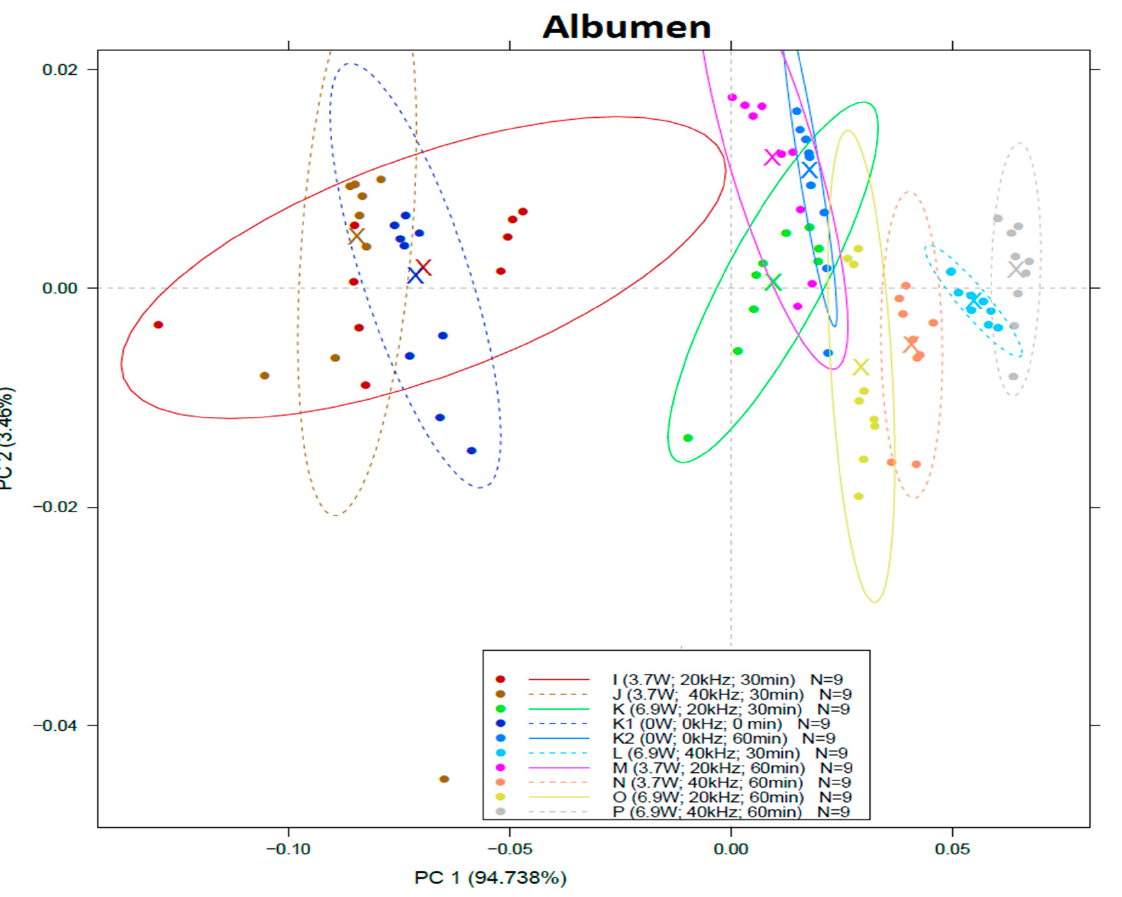
Figure 3. Score plot of principal component analysis (PCA) on spectral data of albumen within the range of 950–1630 nm.